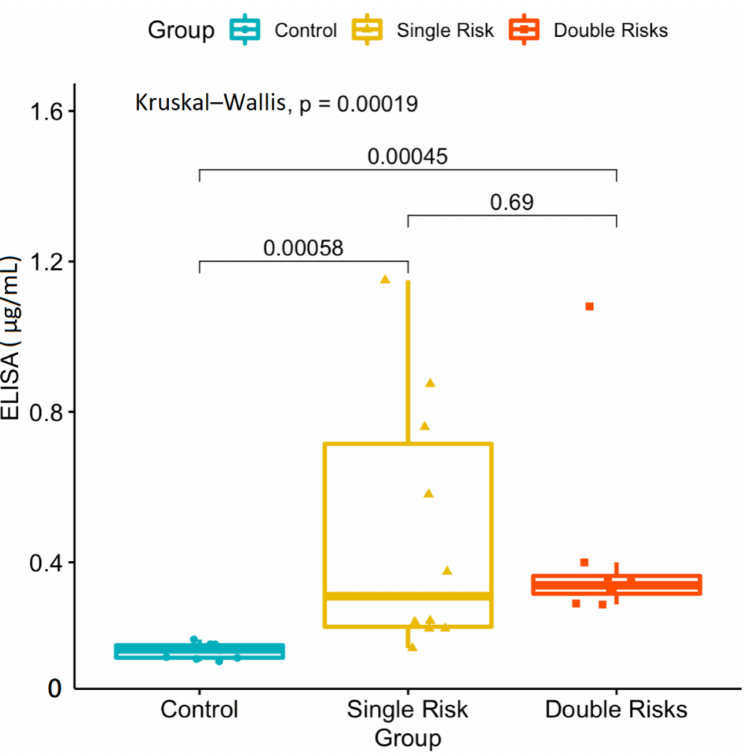
Figure 5. ELISA analysis of significant concentration ( µ g/mL) changes of the